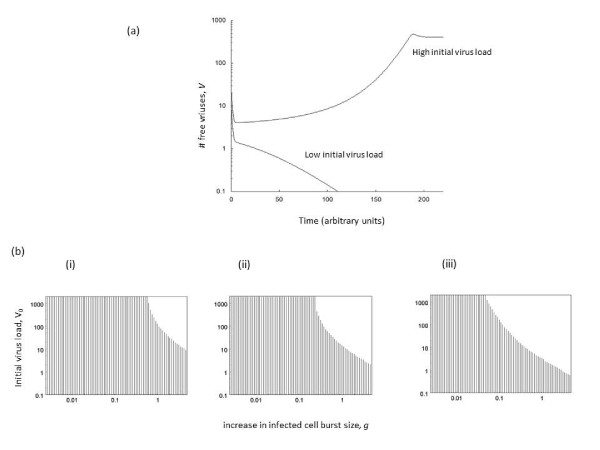
Dependence of model outcome on the initial virus load. (a) Two time series that only differ in the initial virus load. In case of the higher initial virus load, the virus population persists. In case of the lower initial virus load, the virus population goes extinct. (b) Graphic showing how the dependence on initial virus load is changed by the degree to which additional resident viruses increase the burst size of infected cells, g. In the stripy area, the virus goes extinct. In the white area initial virus load is sufficiently high and a successful infection is established. Panels i-iii show cases with increasing viral infection rates. Parameters were chosen as follows. (a) λ = 10; d = 0.1; β = 0.02; a = 0.2; k = 4; u = 1; ϵ = 1; g = 0.75; η = 0.5; n = 200. x(0) = λ/d; yi(0) = 0, v(0) = 25 vs 10. (b) λ = 10; d = 0.1; a = 0.2; k = 4; u = 1; ϵ = 1; g = 0.75; η = 0.5; n = 200. (i) β = 0.015, (ii) β = 0.02, (iii) β = 0.023.